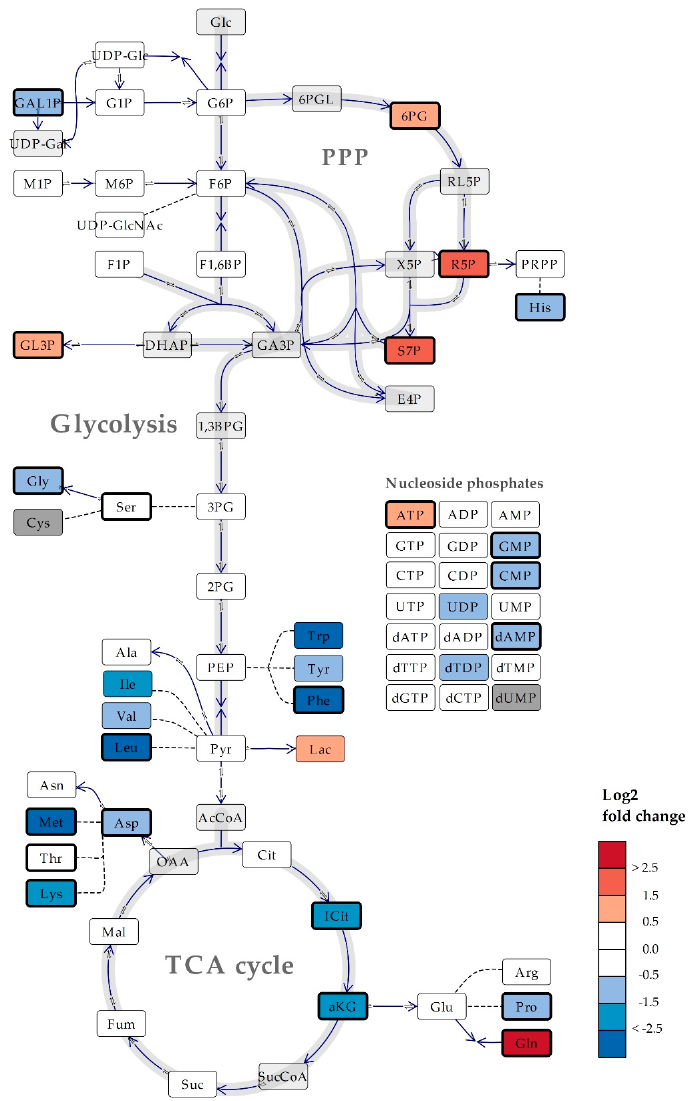
Figure 4. Simplified schematic overview of central carbon metabolism in Saccharomyces cerevisiae , with heat map of the log 2 fold change of average metabolite levels in cells cultured in mineral versus rich media. Bold lined rectangles indicate statistically significant metabolite levels (Two-tailed T-test, adjusted p -value (FDR) = 0.05). Levels of metabolites colored dark grey were < limit of quantification / detection. Metabolites colored light grey were not measured. Direct reactions are indicated by continuous lines, a series of reactions are indicated by dashed lines. Co-enzymes and -substrates are not included. TCA; tricarboxylic acid, PPP, pentose phosphate pathway; Glc, glucose; 6PGL, 6-phosphogluconic acid; RL5P, ribulose 5-phosphate; X5P, xylulose 5-phosphate; UDP-gal, UDP-galactose; DHAP, dihydroxyacetone phosphate; GA3P, glyceraldehyde 3-phosphate; 1,3BPG, 1,3-bisphosphoclyceric acid; AcCoA, Acetyl-CoA; SucCoA, Succinyl-CoA; OAA, oxaloacetic acid. Abbreviations for quantified metabolites are listed in Table